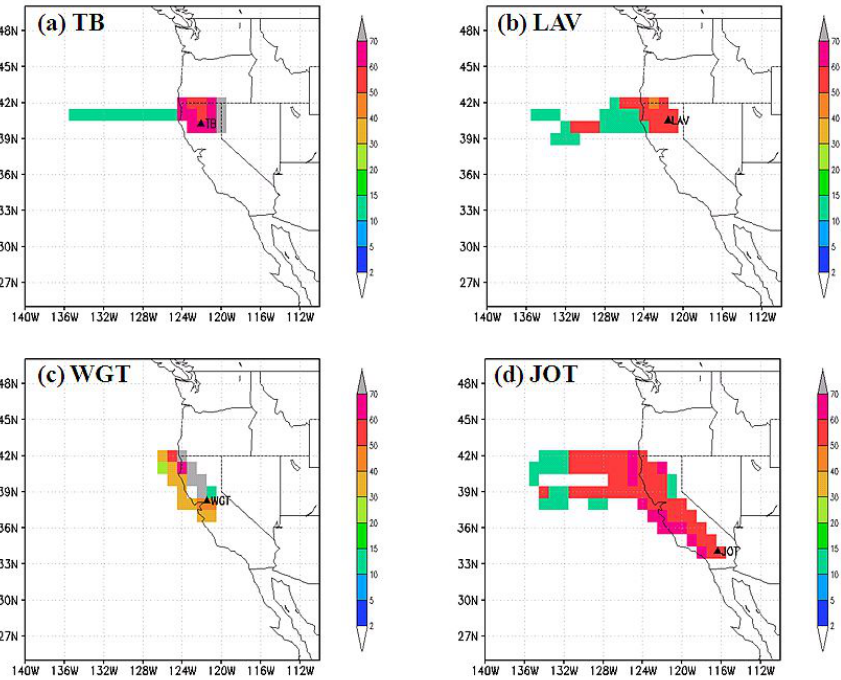
Fig. 8. Reconstructed O 3 concentrations along three-day back trajectories from 12km meteorological fields originating at (a) TB (b) LAV (c) WGT and (d) JOT on 23